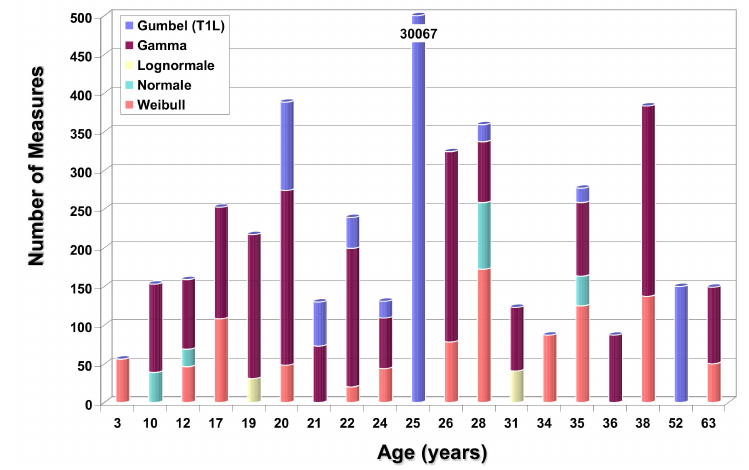
Figure 11. Distribution of the number of measurements that follows a given pdf according to the age of structures.